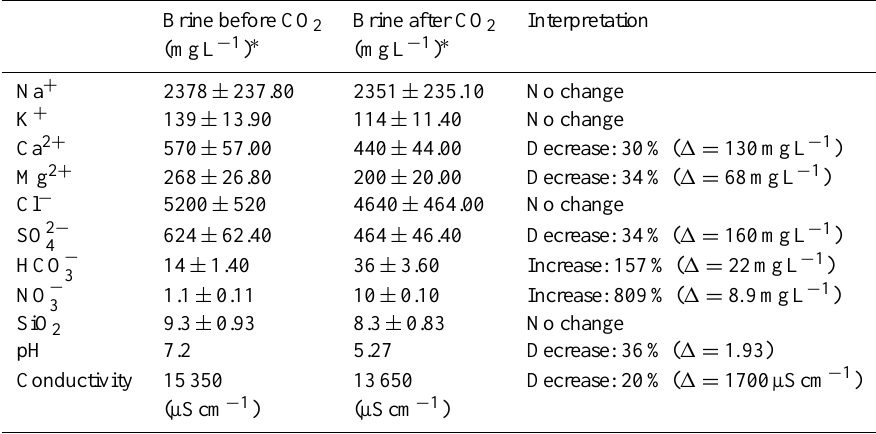
Table 2. Chemical composition of brine before and after the experiment.